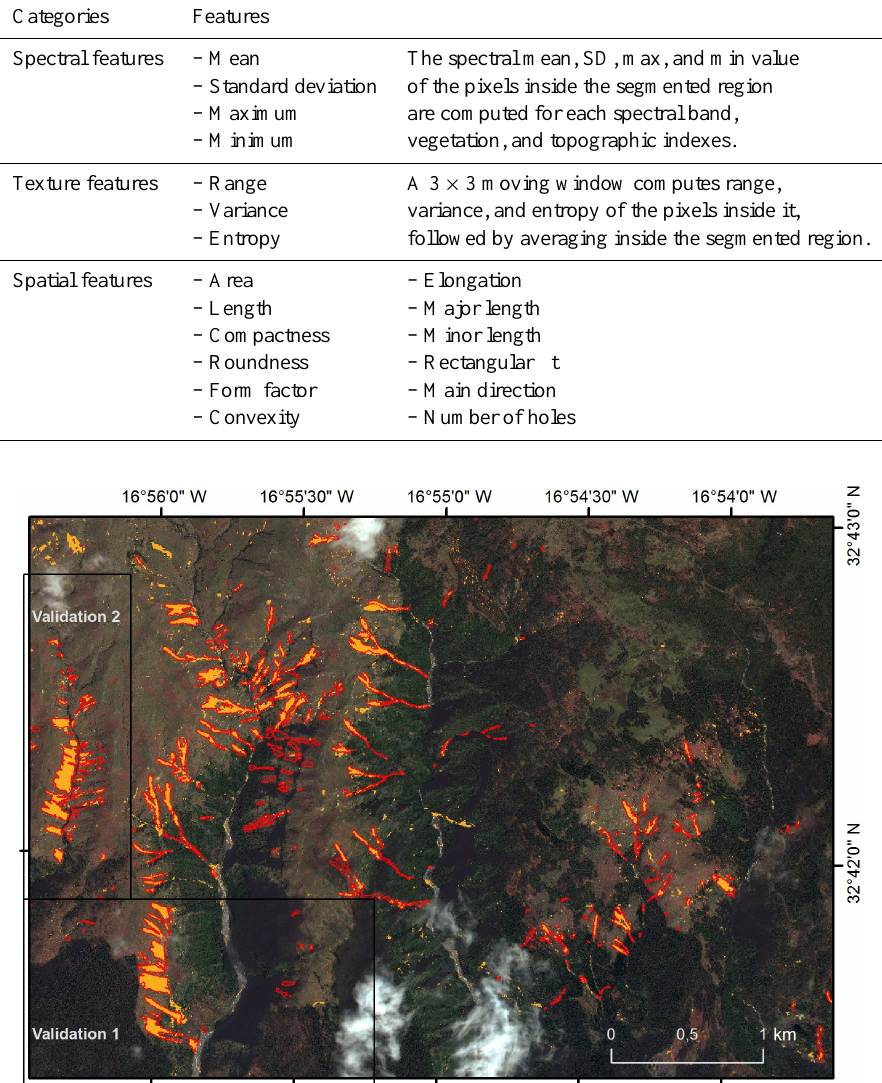
Figure 5. GeoEye-1 pan-sharpened RGB image over the study area (15km 2 ) showing the results of object-based SVM (RBF) landslide mapping. The area automatically classified as landslide (yellow fill) is compared to inventory reference data (red contours). Outlines of validation areas 1 and 2 also